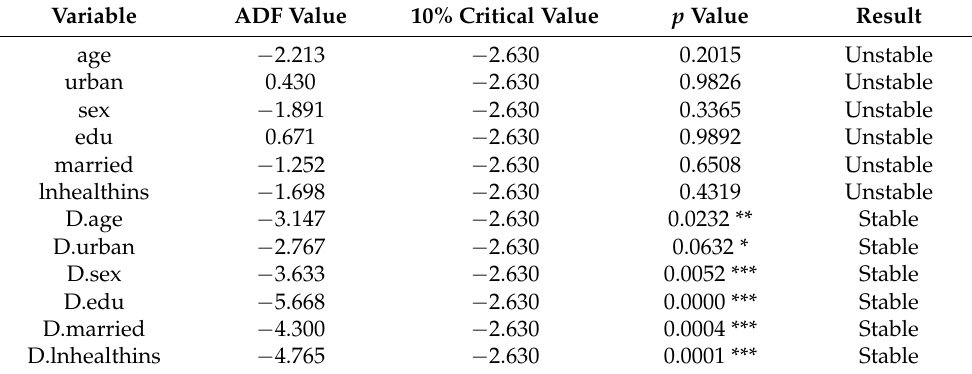
Table 2. Stability test results of each variable datum.